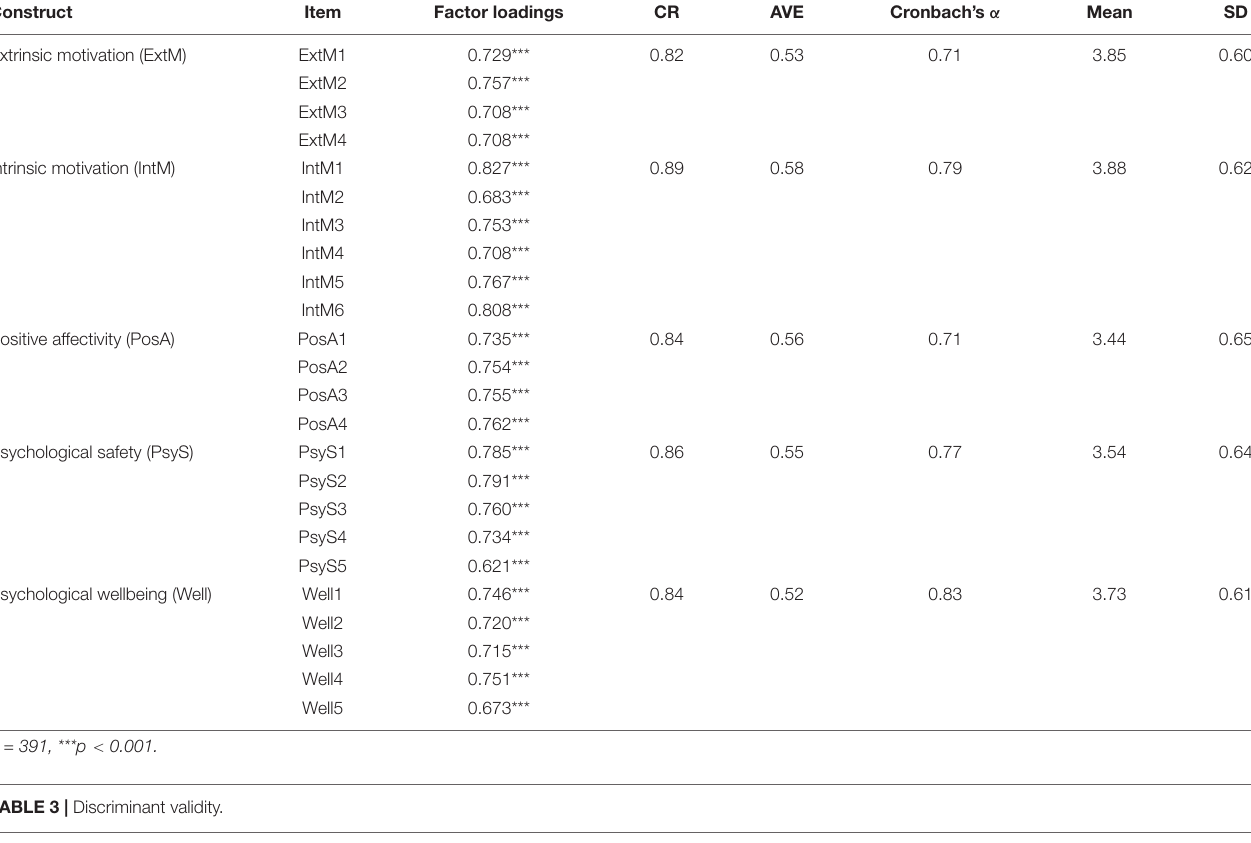
TABLE 2 | Results of the measurement model.